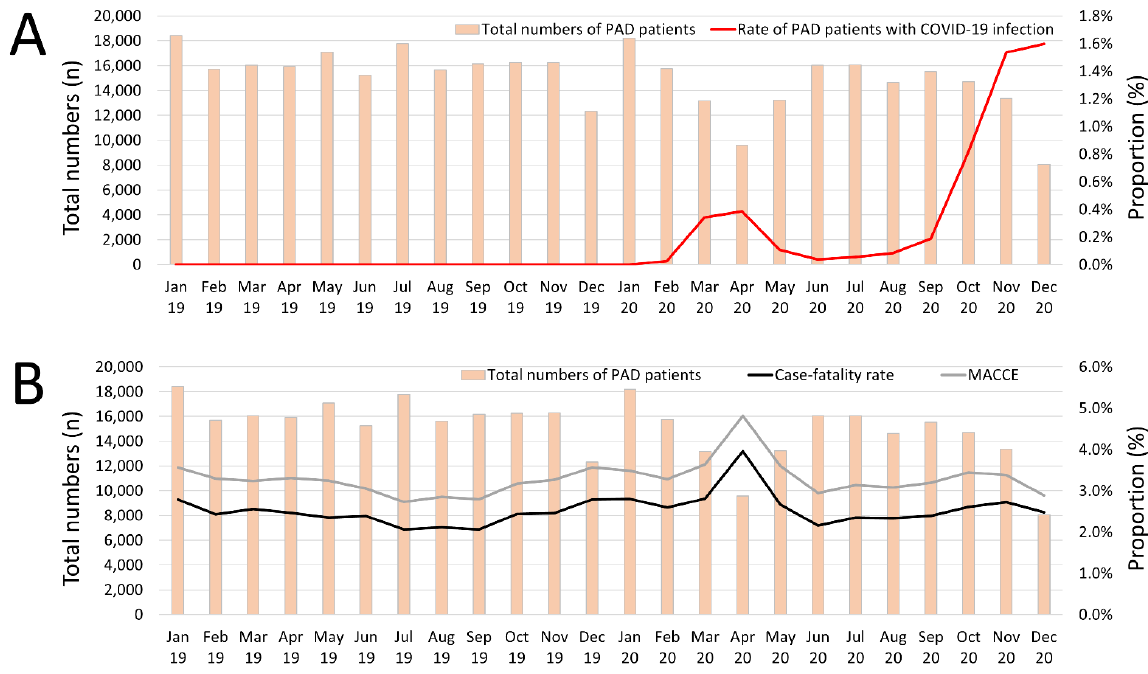
Figure 1. Temporal trends regarding absolute numbers of hospitalizations due to PAD and proportion in these patients with COVID-19 infection, case fatality rate and MACCE rate. ( A ): Temporal trends regarding absolute numbers of hospitalizations of PAD patients (orange bars), and proportion of PAD patients with confirmed COVID-19 infection (orange line) stratified for treatment month. ( B ): Temporal trends regarding absolute numbers of hospitalizations of PAD patients (orange bars), and case fatality rate (black line) as well as MACCE rate (grey line) stratified for treatment month.